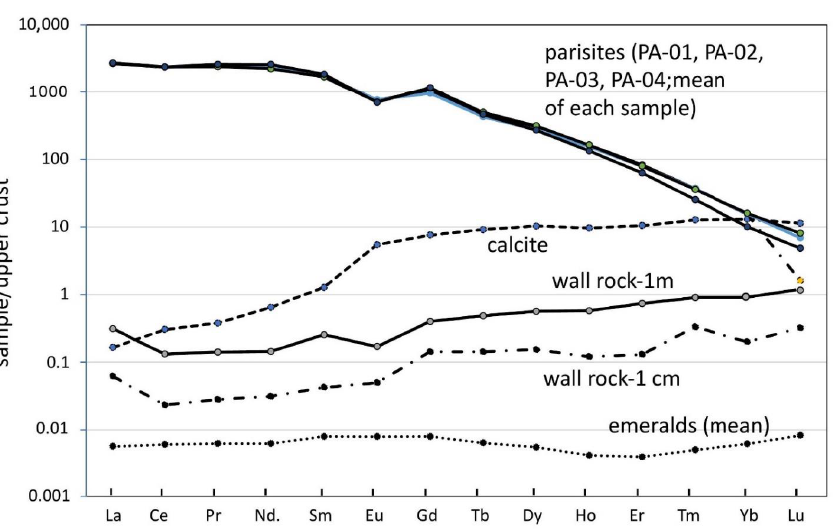
Figure 3. Mean REE concentrations of four parisites (mean of 13–23 samples) and their coexisting minerals and wall rock system. REE are upper crustal-normalized (Rudnick et al., 2003).